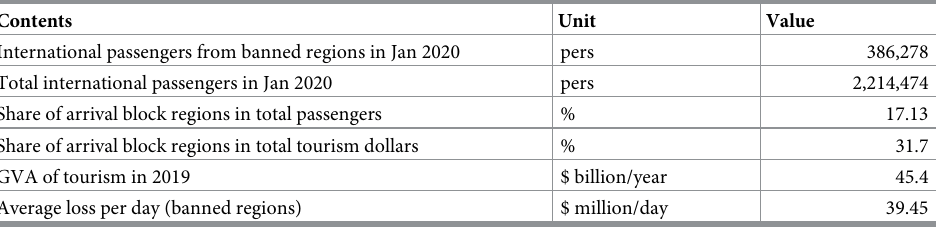
Table 5. Cost of international arrival